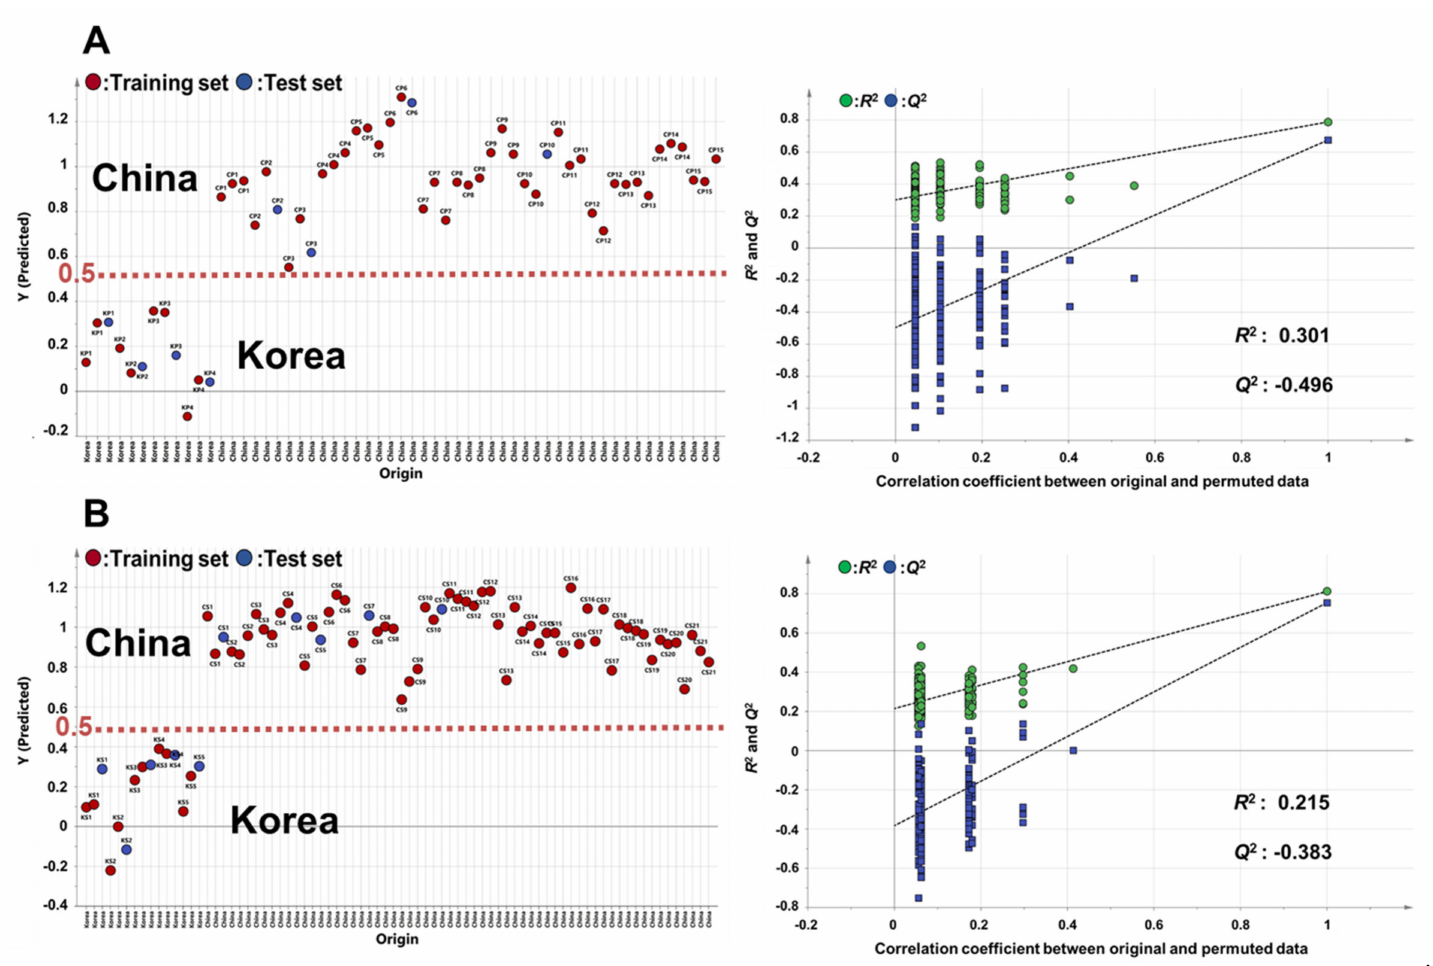
Figure 2. External validation test and permutation test by OPLS-DA for discriminating the geographic origin of ( A ) perilla and ( B ) sesame seeds from Korea and China. The number of permutations for the permutation test was 200. (A: R 2 X = 0.298, R 2 Y = 0.788, Q 2 = 0.674, RMSEP = 0.229; B: R 2 X = 0.320, R 2 Y = 0.812, Q 2 = 0.754, RMSEP =